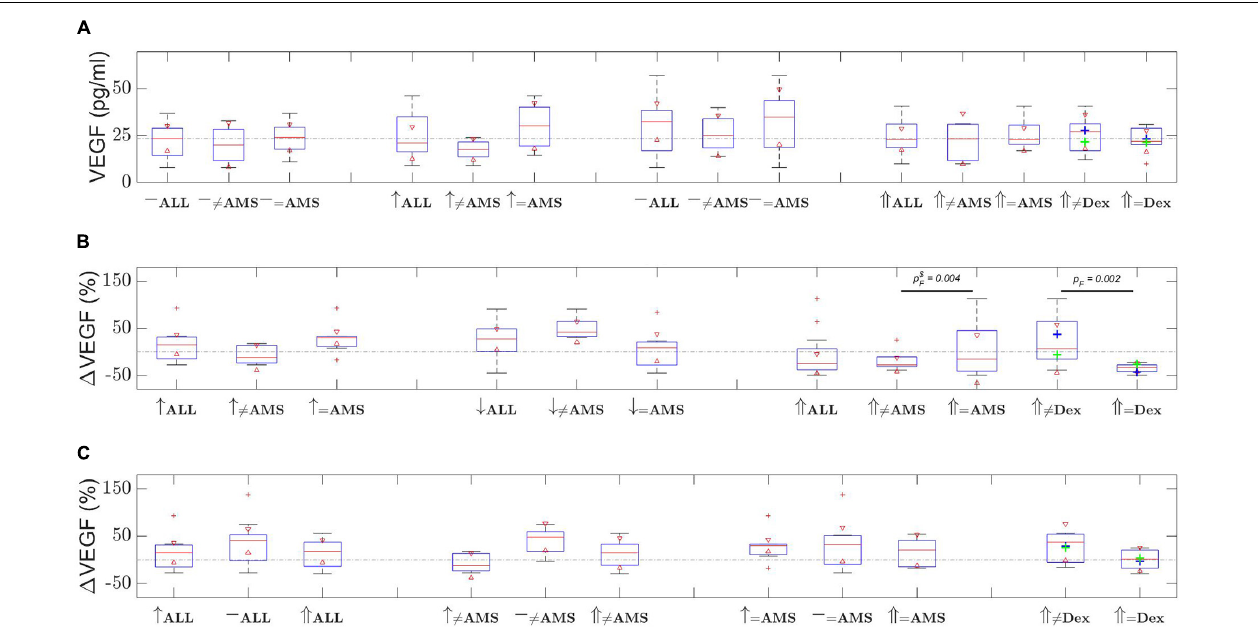
FIGURE 1 | VEGF changes over the time course of the two ascents. Shown are (A) distribution of VEGF level measurements, (B) relative change in VEGF level with respect to last measurement, and (C) relative change in VEGF level with respect to first baseline measurements. Time evolves left to right in (A,B) , and in (C) dotted line depicts the 0% change level. [Red triangles represent boxplot notches at the 95% confidence level; whiskers correspond with one standard deviation from the mean; red plusses are outliers; green plus is first ascent non-AMS mean, blue plus is AMS mean; (cid:54)= non-AMS or non-dexamethasone (Dex); ↑ first ascent; ↓ descent; ⇑ second ascent; – either first or second baseline; p F is the F -test p -value and $ means outlier was removed; the dash-dot line in (A) depicts the first baseline mean, in (B,C) they show the 0% change, provided as a guide in all